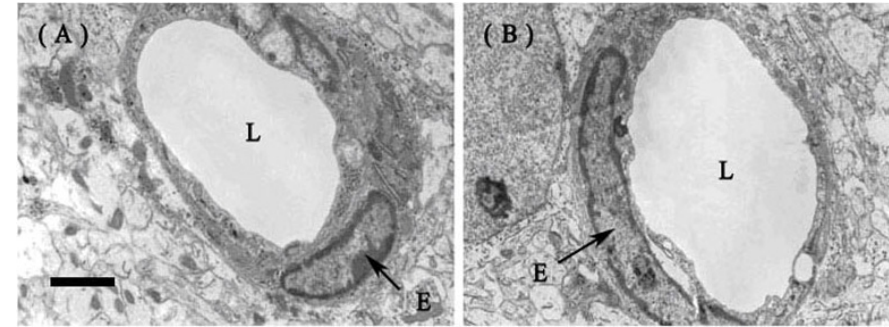
Figure 2. Representative photographs of transmission electron microscopy for the neonatal rat brain at P1. ( A ) The capillaries remained normal and the endothelial cells and tight junctions were intact in the parenchyma of the rat brain (frontal cortex) 12 h after ip. injection of LPS; ( B ) The brain (frontal cortex) of the control rat 12 h after ip. injection of NS. (L, luminal surface; E, endothelial cell). Bar for A and B , 1